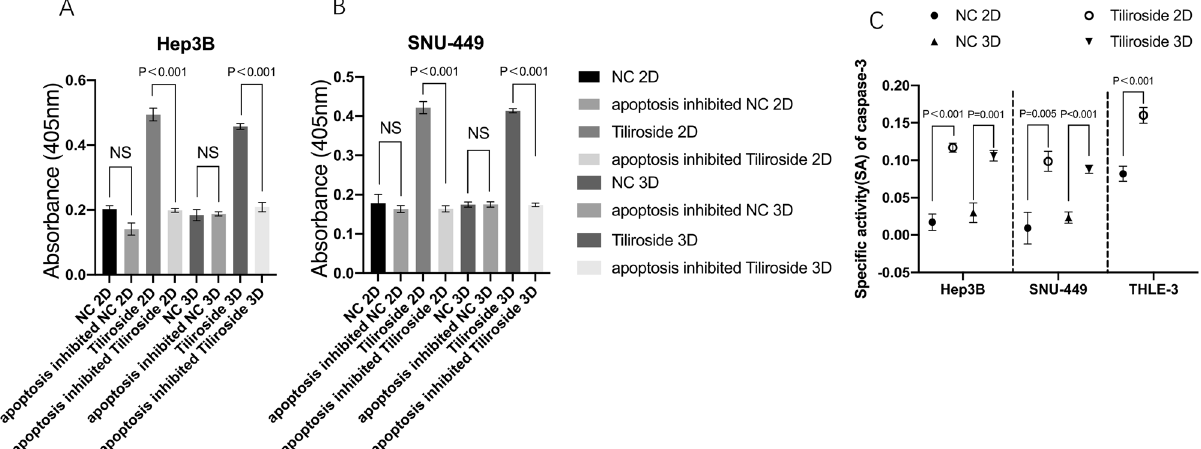
Figure 5. Tiliroside elevated the activity of Caspase-3. After 48 h intervention of 40 μM Tiliroside or DMSO, the absorbance was significant higher in the Tiliroside group than NC, apoptosis inhibited NC and apoptosis inhibited Tiliroside group in Hep3B ( A ) and SNU-449 ( B ), cultured in either 2D or 3D systems, respectively. CASP3-specific activities were also significantly higher in Tiliroside treated group compared to NC in Hep3B, SNU-449 and THLE-3 cells ( C ); NC negative control, NS